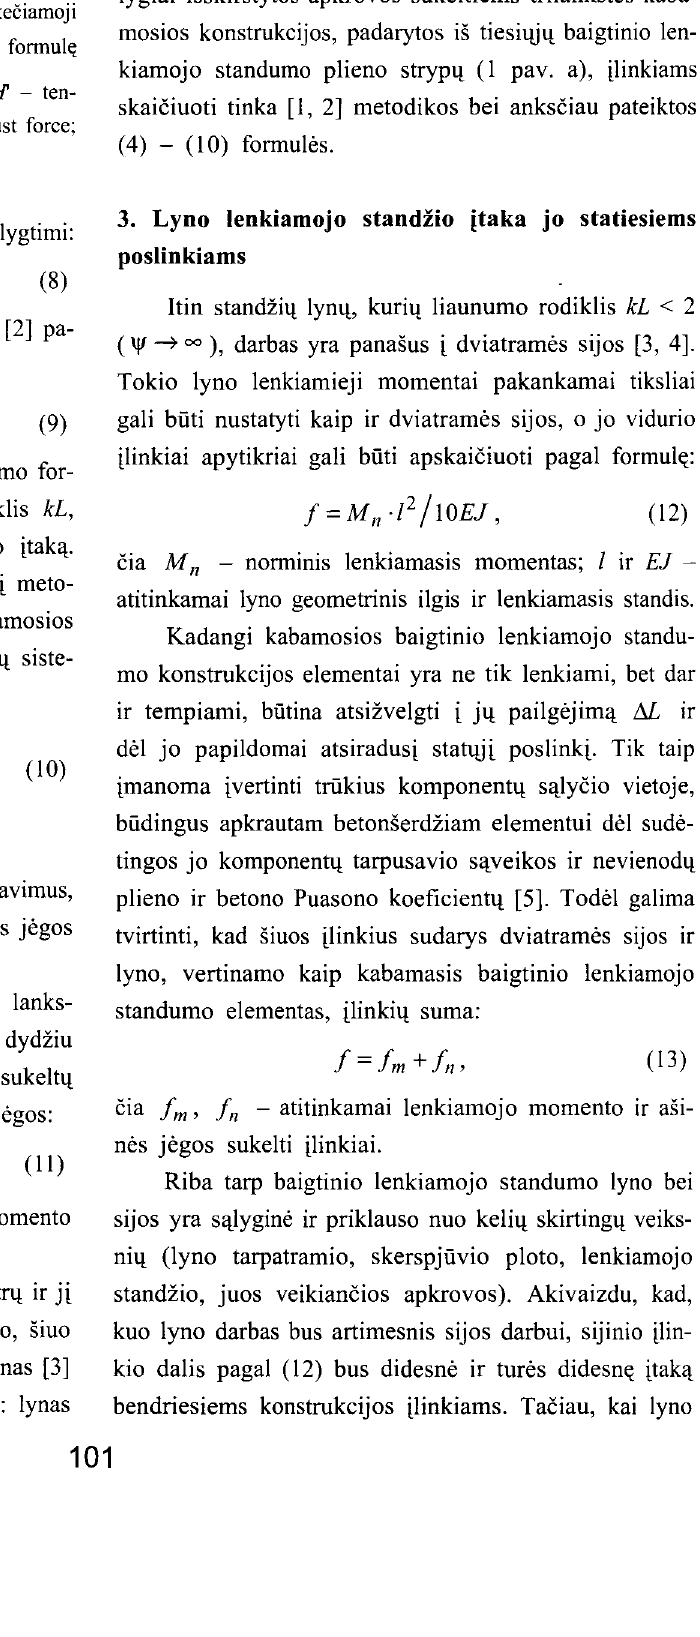
Fig 3. Design diagram of straight-line cable: H - ten sion force of cable; !t.f' = !t.f ·cos a